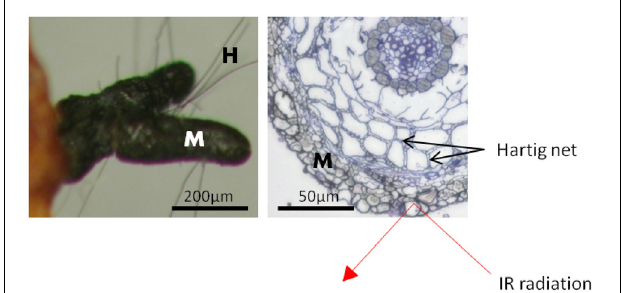
FIGURE 1 | Scheme of a beech root tip colonized by the ectomycorrhizal fungus Cenoccocum geophilum . The fungus enwraps the root tip with a hyphal mantle [M] composed of several layers. The Hartig net is formed by fungal hyphae between cortex cells. Short hyphae [H] extend from the mantle into the surroundings. The penetration depth of the infrared radiation (IR), of about 2 μ m, is limited to the outer layer of the fungal mantle. Scale bar: 50 μ